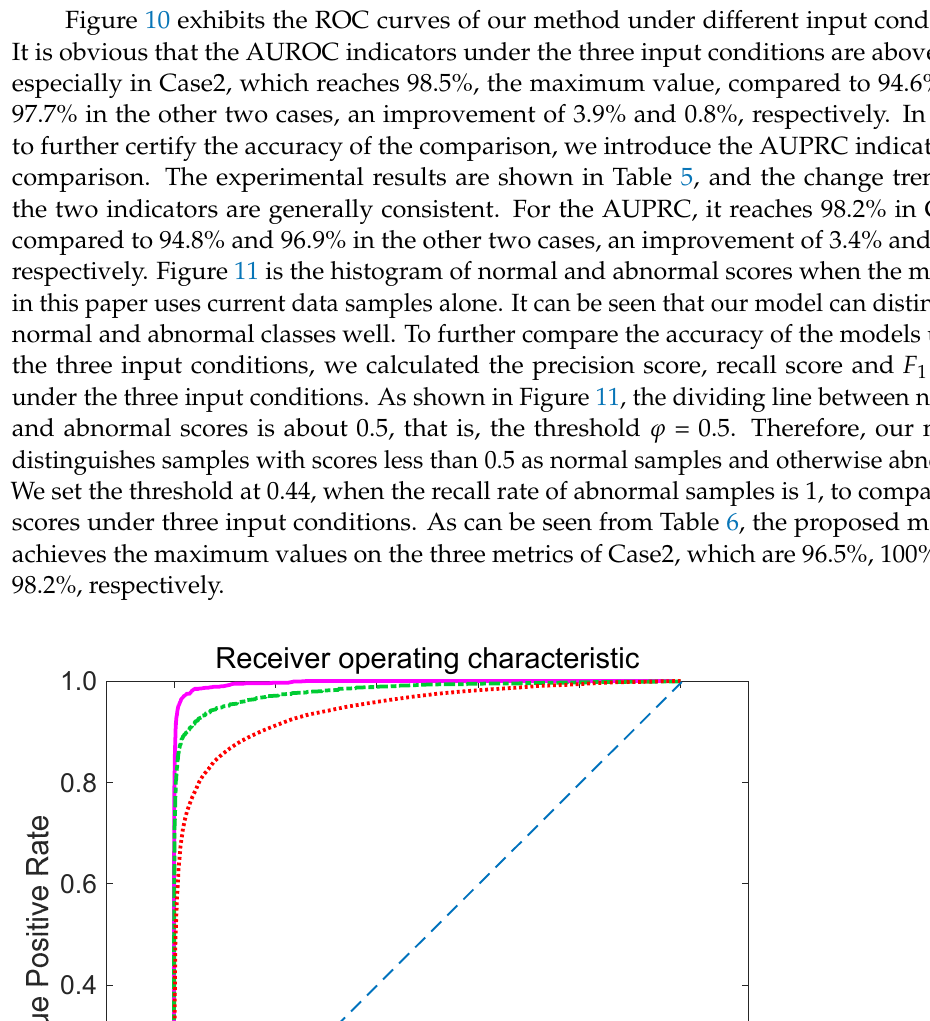
Figure 11. Histograms of normal and abnormal scores for samples of current data tested with our method. Table 5. Experimental results of our method under three input conditions. Case